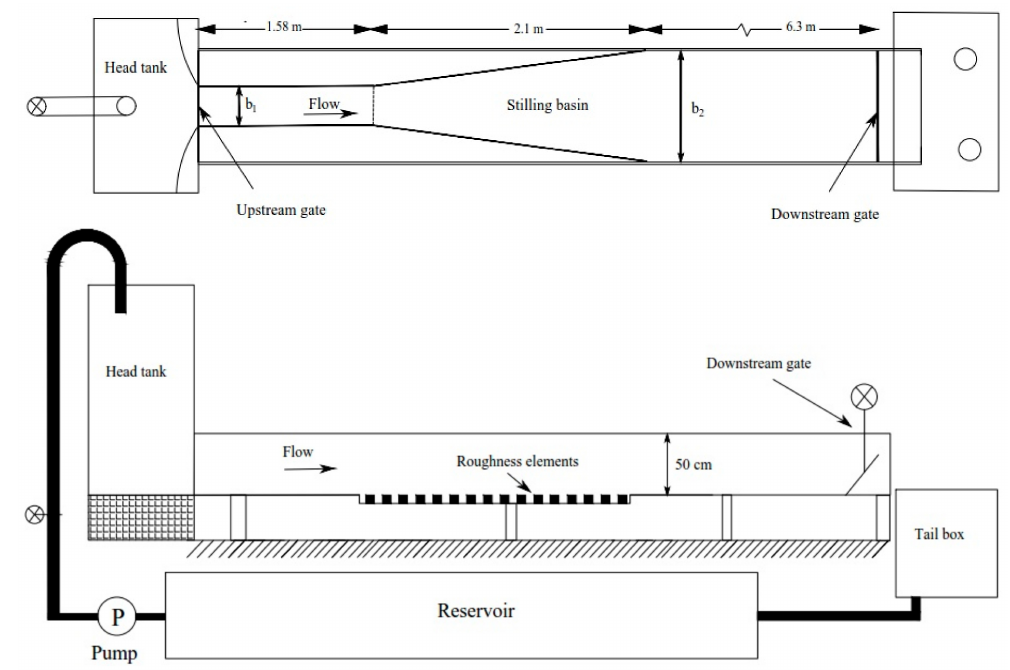
Figure 2. Plan and side view of the experimental set-up.